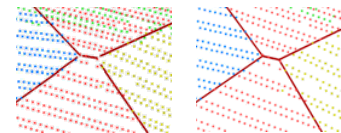
Figure 4: Geometric fitting of roof corner, associated with ridge-lines: before (left) and after fitting (right)